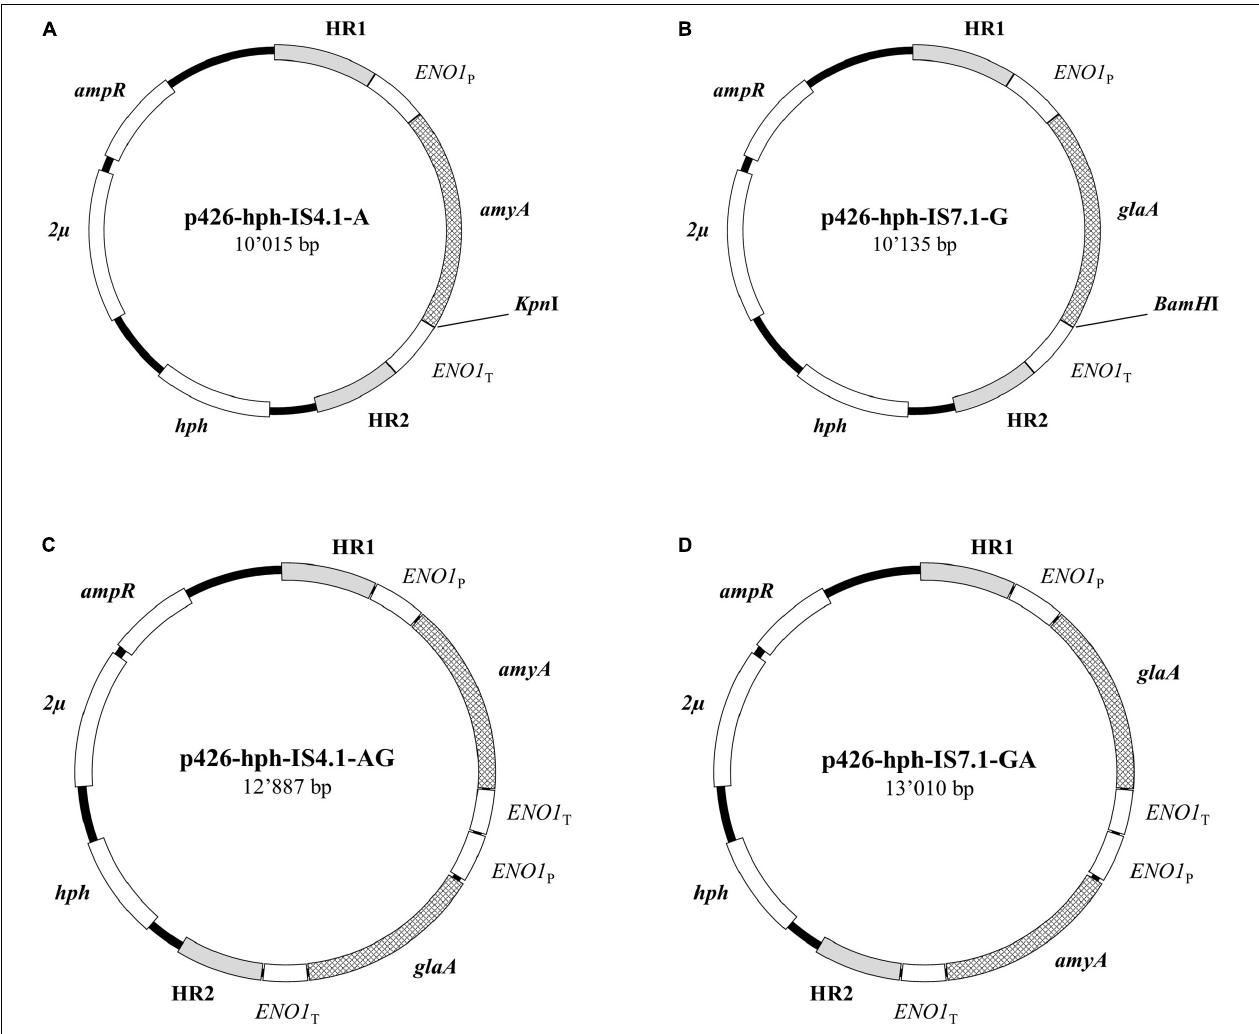
FIGURE 1 | Donor DNA plasmids for the CRISPR/Cas9 method used in this study: plasmids were constructed to carry single A. tubingensis amyA (A) or glaA (B) or double cassette for the simultaneous expression of the A. tubingensis amyA and glaA genes (C,D) . IS4.1 and IS7.1 indicate the locus position for gene integration. The homologous regions (HR1 and HR2) are sequences flanking the designated genomic locus. All plasmids contained bacterial ori and amp genes for plasmid replication and ampicillin resistance,